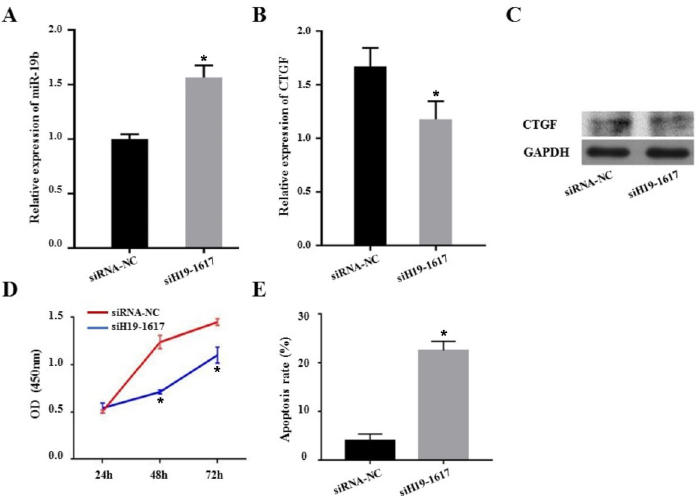
Figure 4. A , Expression of miR- 19b after silencing H19 . B , CTGF expression after silencing H19 . C , Expression of CTGF protein after silencing H19 . D , The proliferative ability of KGN cells after silencing H19 was detected by CCK8 at 24, 48, and 72 h. E . KGN cells apoptosis after silencing H19 was detected by fl ow cytometry. *P o 0.05 compared to negative control (NC). Data are reported as means ± SD ( t -test).